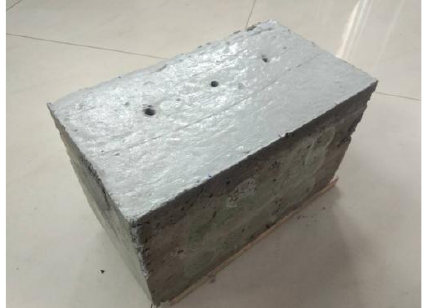
Figure 5. Concrete block I.